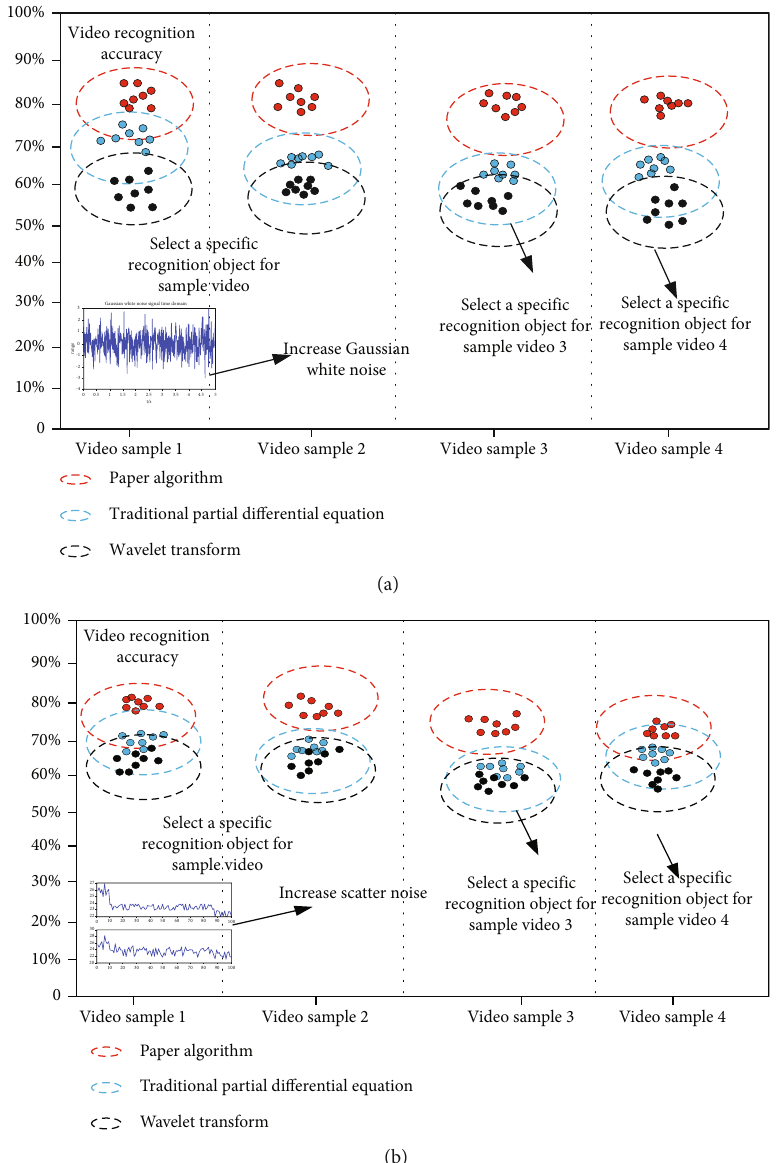
Figure 8: (a) Recognition accuracy curve of di ff erent algorithms for given targets under four groups of sample videos in complex environment (Gaussian white noise). (b) Recognition accuracy curve of di ff erent algorithms for given targets under four groups of sample videos in complex environment (shot